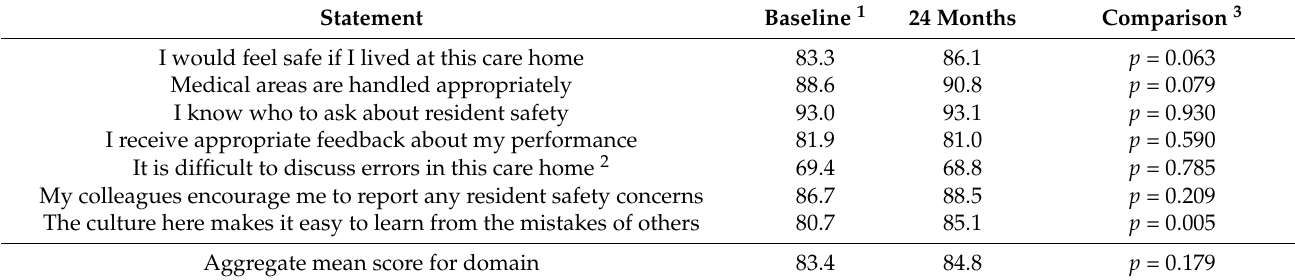
Table 2. Comparison of mean SAQ safety climate scores between baseline and 24